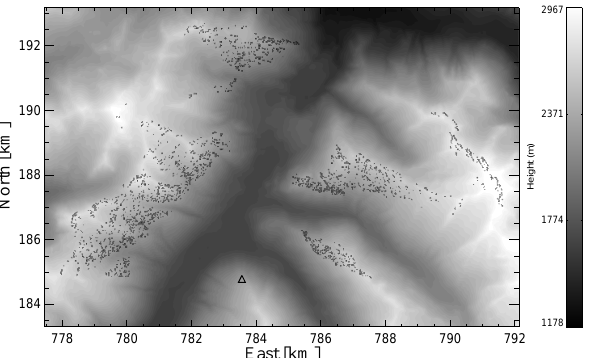
Fig. 7. Projected ground echoes, superimposed on the DEM provided by Swisstopo (Swiss projection system MN03). The radar location is indicated by the triangle.